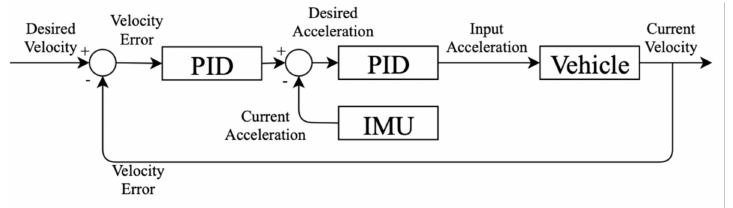
Figure 11. Process flow of the vehicle longitudinal controller.